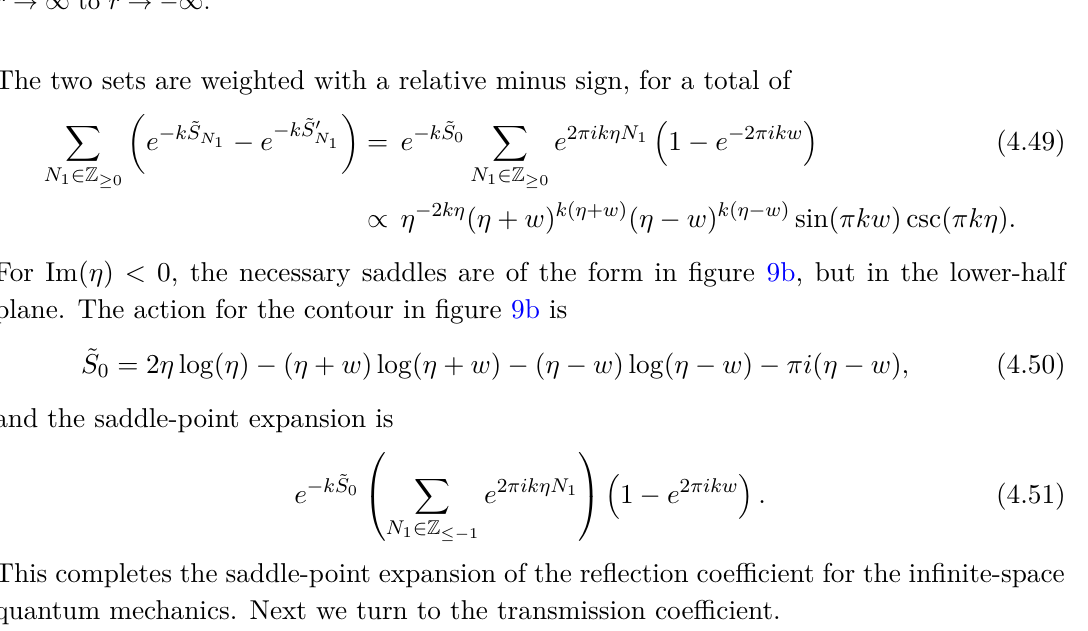
Figure 10. Transmitted saddle. ( η > w ). For η real and greater than w , there is a real saddle for the transmission coefficient, corresponding to a particle that rolls over the inverted potential from r → ∞ to r → −∞